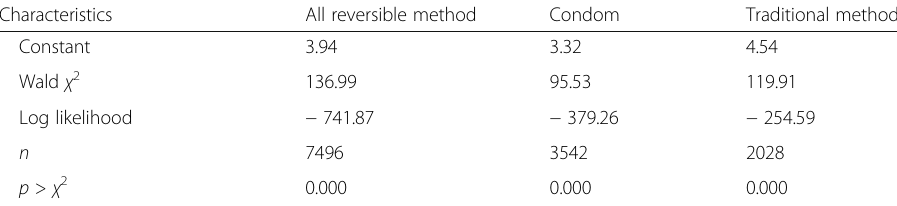
Table 4 Results from Weibull hazard regression of contraceptive failure rates within 1 year of method adoption for all methods combined traditional method and for condom, by selected characteristics of female users, Uttar Pradesh, 2009 – 14